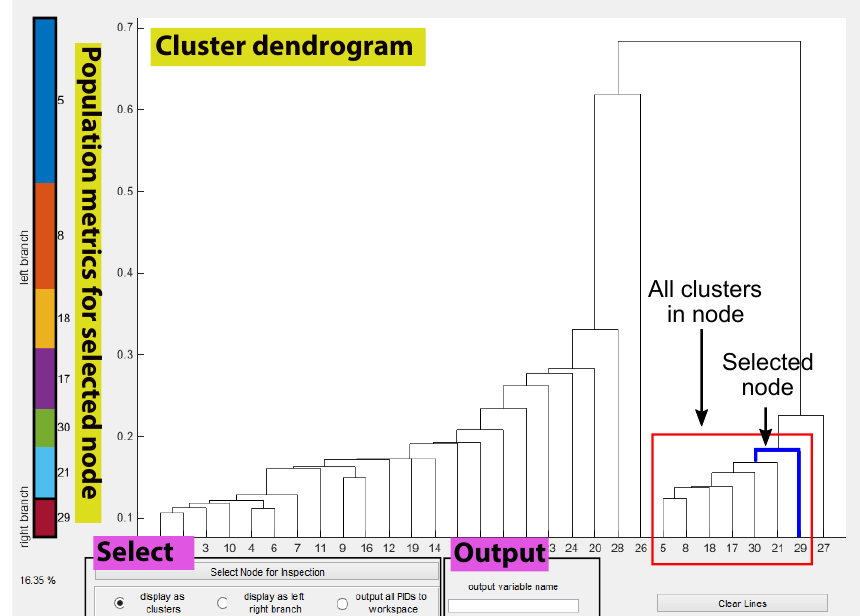
Figure 2. Screen capture of a dendroFATES window showing the cluster tree or dendrogram for 30 input clusters. The cluster contributions to the user-selected node are shown in the plot on the left. The particle data for the selected node are automatically plotted in a guiFATES window (Fig.